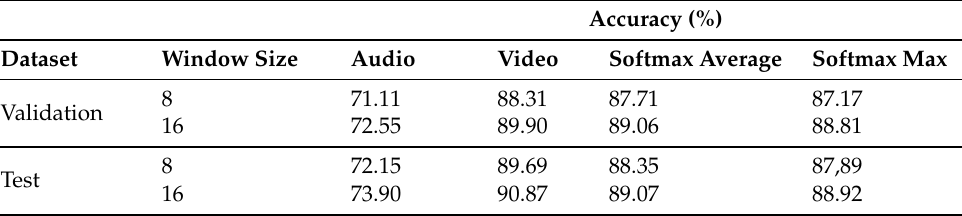
Table 4. Comparison of the accuracy of classification on the validation and test sets, for different models and late fusion alternatives. The audio model is described in Section 3.4, and the video-based 3D-CNN model is described in Section 3.2. The fusion of the audio and video features is performed using either softmax average or softmax max, as described in Section 4.